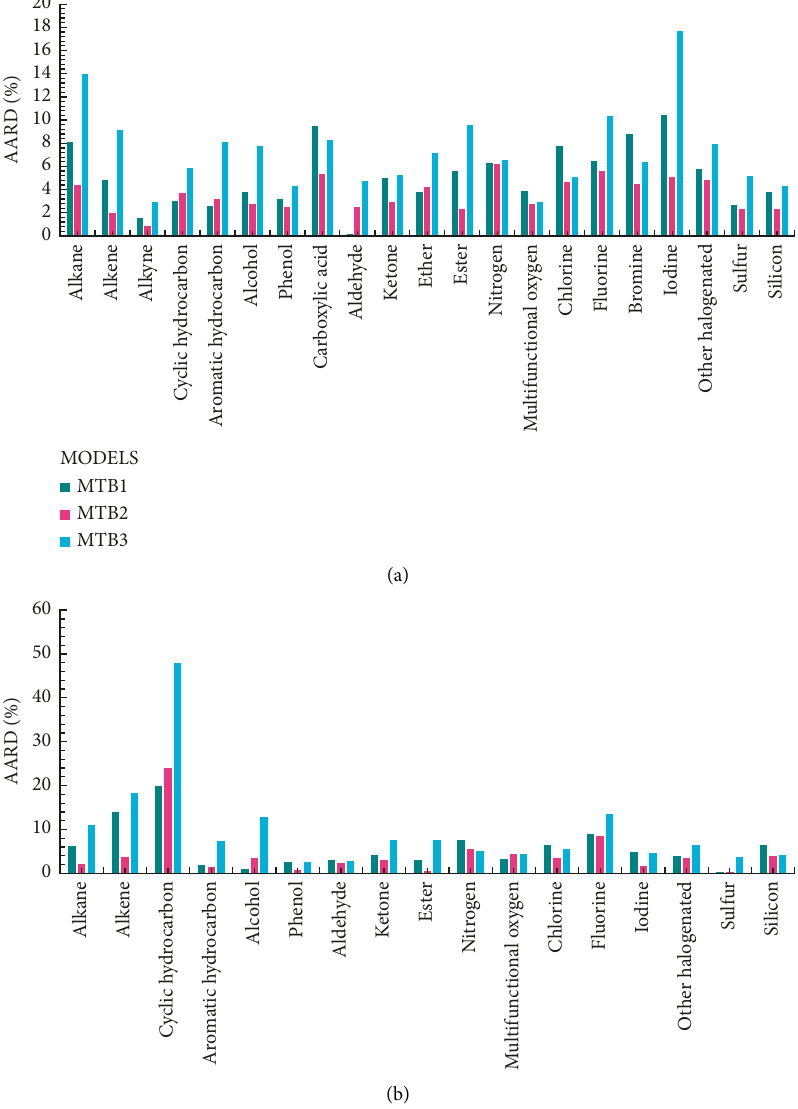
Figure 2: AARD for the calculation of the normal boiling point of pure compounds using different first-order GCMs. (a) Correlation and (b)